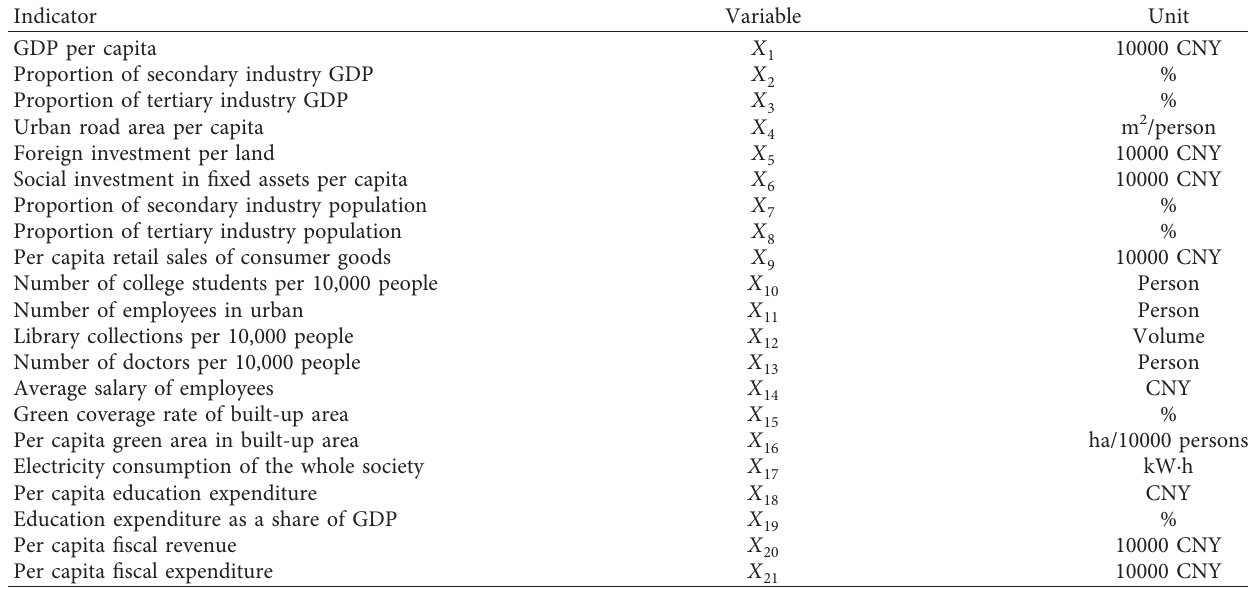
Table 1: Driving factors of